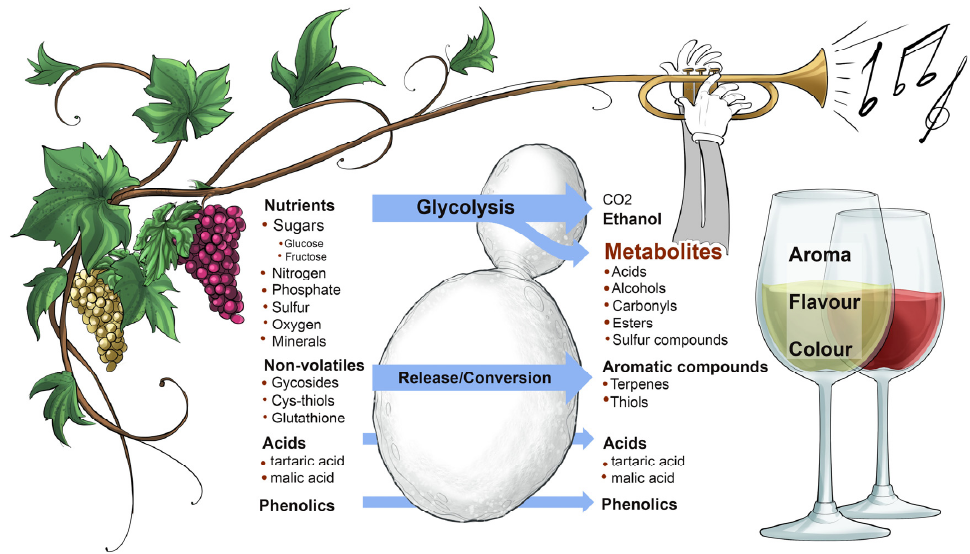
Figure 11. The conversion of grape juice to wine by the action of the yeast, Saccharomyces cerevisiae